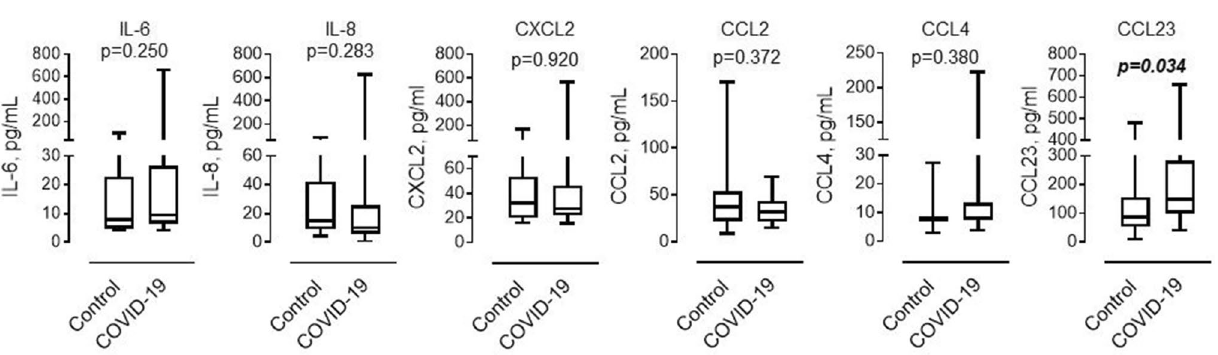
Figure 4. Level of circulating pro-inflammatory factors in control and COVID-19 subjects. Levels of circulating cytokines and chemokines were determined in platelet-free plasma in groups of control subjects ( n = 12) and COVID-19 patients ( n = 25). One patient with extracorporeal membrane oxygenation support was excluded from the analysis due to the potential effect of cytokine adsorption during ECMO therapy. Mann–Whitney